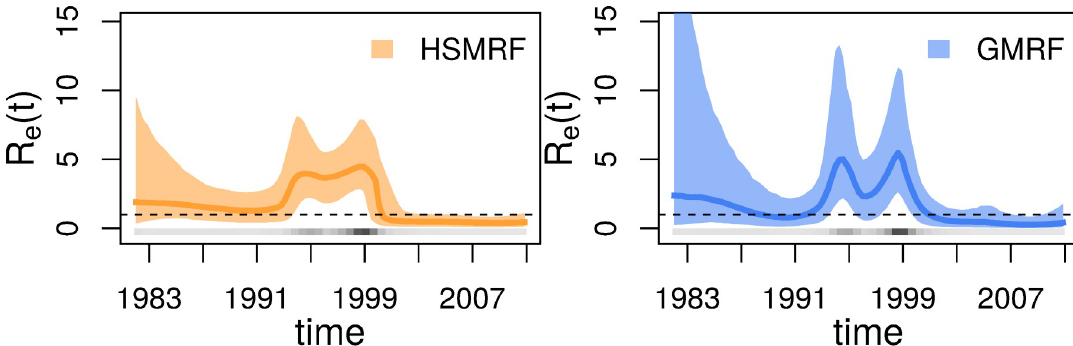
Fig 8. Analyses of the HIV dataset. Plotted are posterior median trajectories (dark lines) and 90% credible intervals (shaded regions). The upper CI for the GMRF-based analysis extends to � 26, we have truncated the figure for a clearer view of the rest of the trajectory. Time is plotted as calendar time. A line at R = 1 is provided for convenience, as below this threshold the epidemic cannot be sustained. e In grey is a heatmap of the inferred divergence